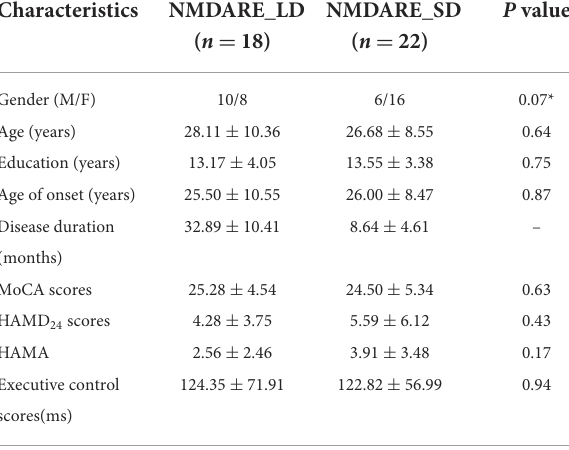
TABLE 4 Comparison of clinical data between the NMDARE_SD and NMDARE_LD. Characteristics